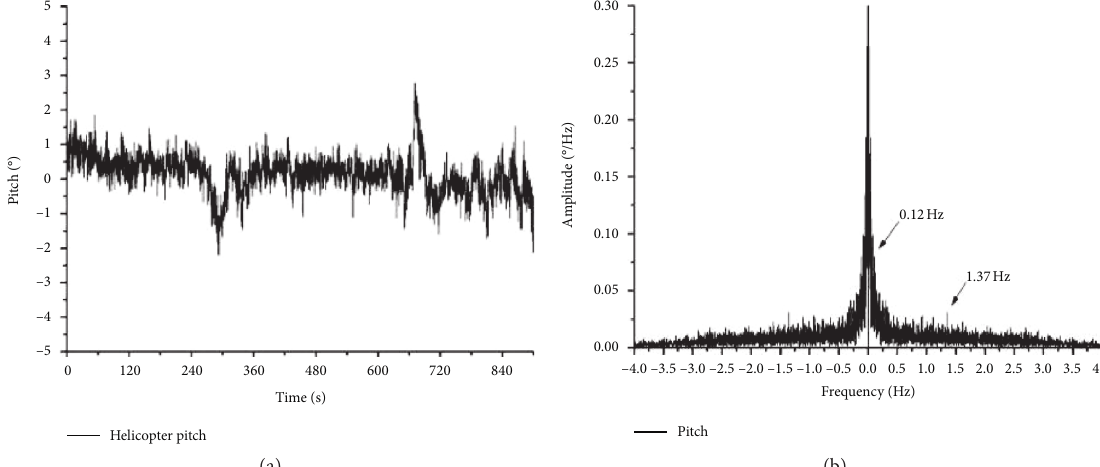
Figure 16: (a) Pitch angle change of helicopter hovering. (b) Pitch spectrum change of helicopter hovering.